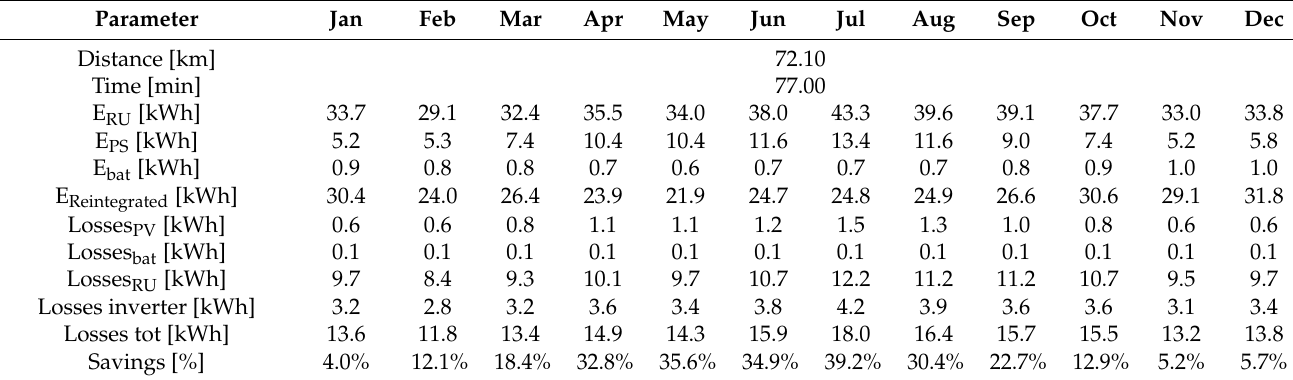
Table 6. Monthly electric consumption in the scenario